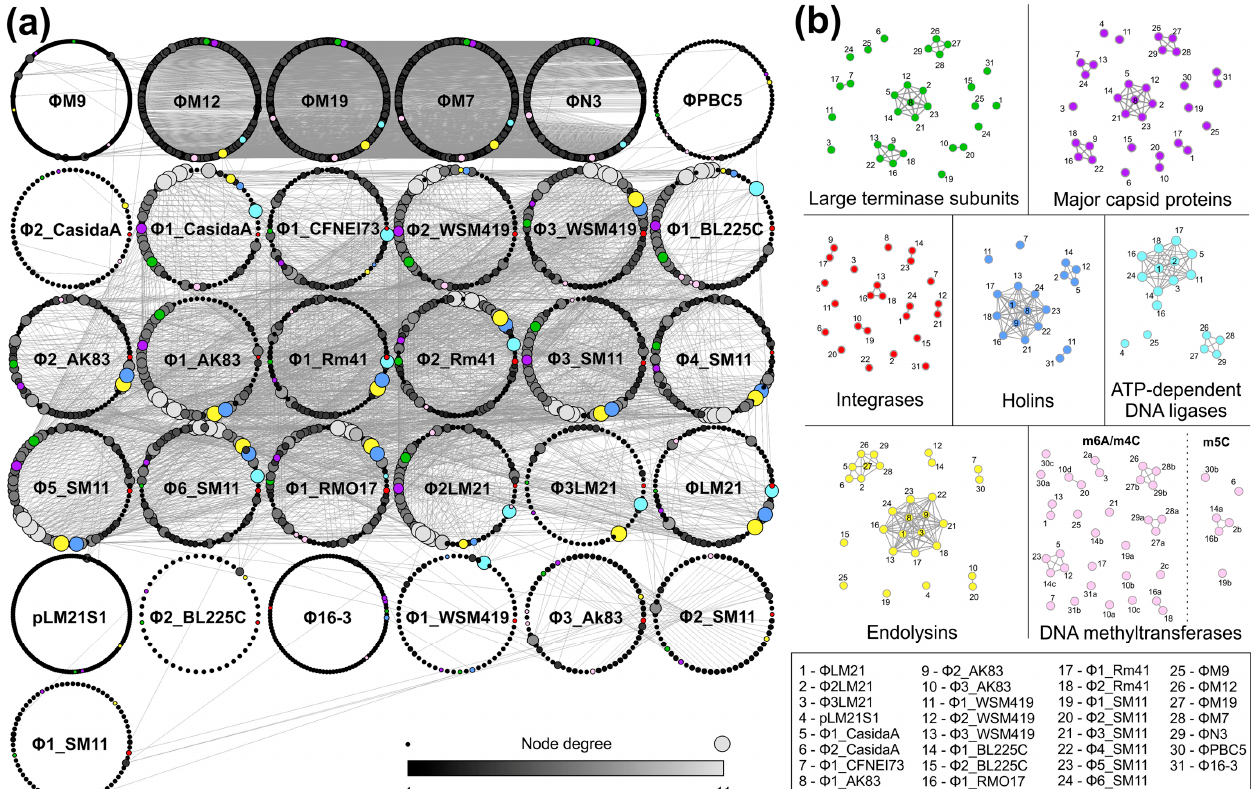
Figure 4. The similarity networks of the proteins encoded within the sinorhizobial phages. ( a ) The similarity network of 3688 sinorhizobial phages proteins. All the proteins (nodes) belonging to the same (pro)phage are circularly arranged and are linked to the others according to their identity value. The resulting picture for 50% threshold is shown. The size and color of each node (single protein) is proportional to its degree, which reflects the number of homologous proteins within the network (the more unique, the smaller and darker the node). Additionally, selected proteins were highlighted: large terminase subunits (green), major capsid proteins (magenta), integrases (red), holins (blue), ATP-dependent DNA ligases (light blue), endolysins (yellow) and DNA methyltransferases (pink). ( b ) Visualization of the similarity networks for selected proteins. The sequences of those proteins were presented as the multifasta files (File S5). Letters a, b and c beside the number of the (pro)phage indicate different DNA MTase encoded within the particular virus.